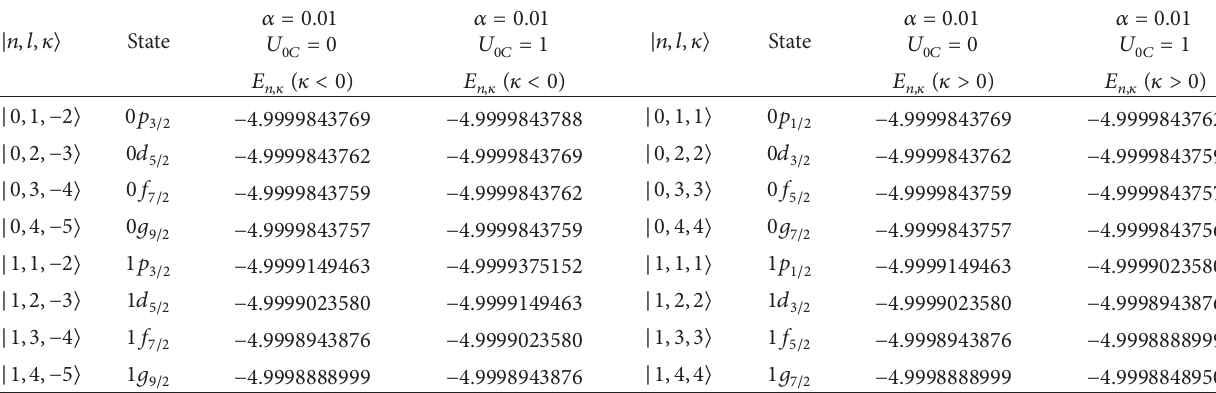
Table 5: The bound state energy eigenvalues in unit of fm −1 of the spin symmetry Coulomb potential for several values of 𝑛 and 𝜅 . Here the first and second states column according to (𝑙,𝑗) .